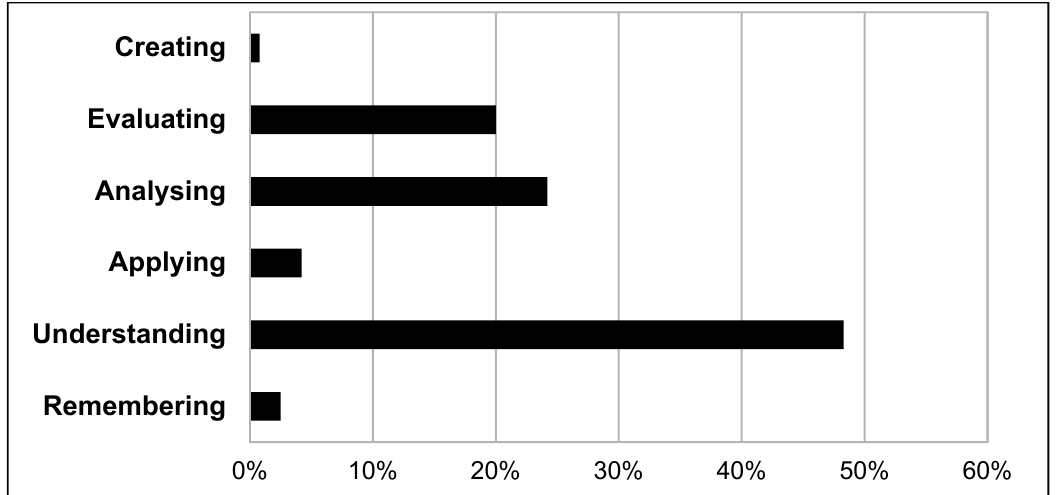
Figure 4. Results from the reflective diaries: distribution and frequency of the different stages of Bloom´s taxonomy based on the patient cases as described by the participating students.